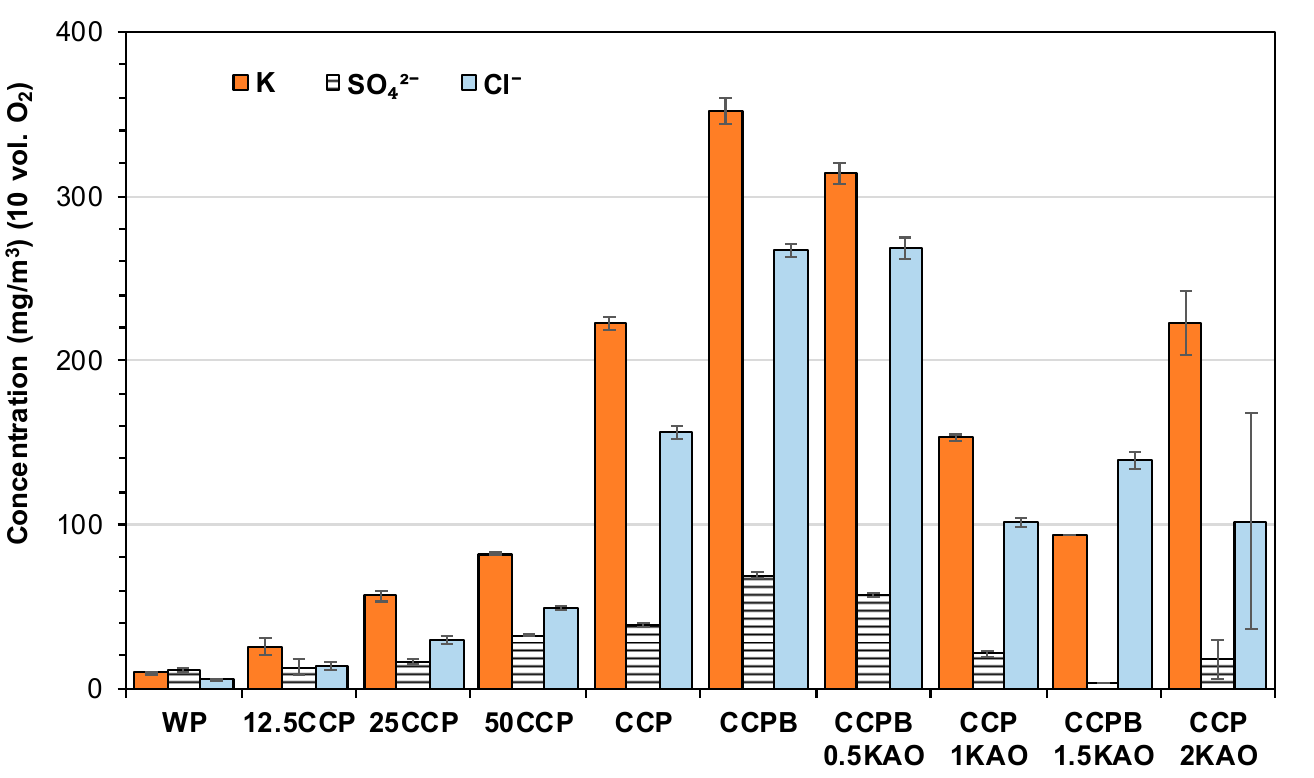
Figure 7. Concentrations of main components in TPM (for experimental list see Table 2).